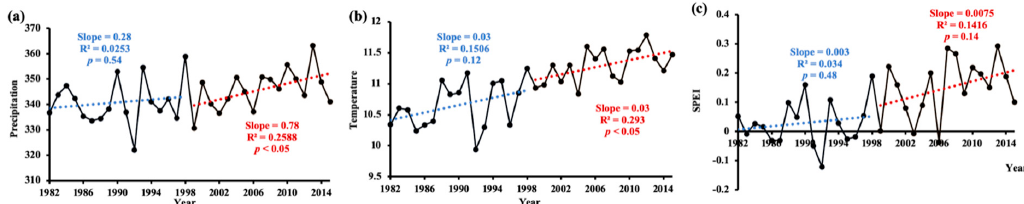
Figure 3. Changing trend of annual ( a ) precipitation, ( b ) temperature, and ( c ) SPEI during 1982–1998 and 1999–2015, respectively. Each year value was averaged of all pixels during the growing season. The blue line is the linear fit of 1982–1998; and the red line is the linear fit of 1999–2015. (Figure 4c,d). Spatial patterns of the SPEI during the two study periods were reflected by their mean values and the standard deviation. Significantly different spatial patterns in the mean SPEI were observed both before and after 1998 (Figure 4). In 1982–1998, the regions with a low SPEI (< − 0.1) accounted for 27.7% of the study area and were mainly located in the high and mid-latitudes, including the middle and northeastern part of Russia, northwestern Canada, and northern Kazakhstan (Figure 4a).